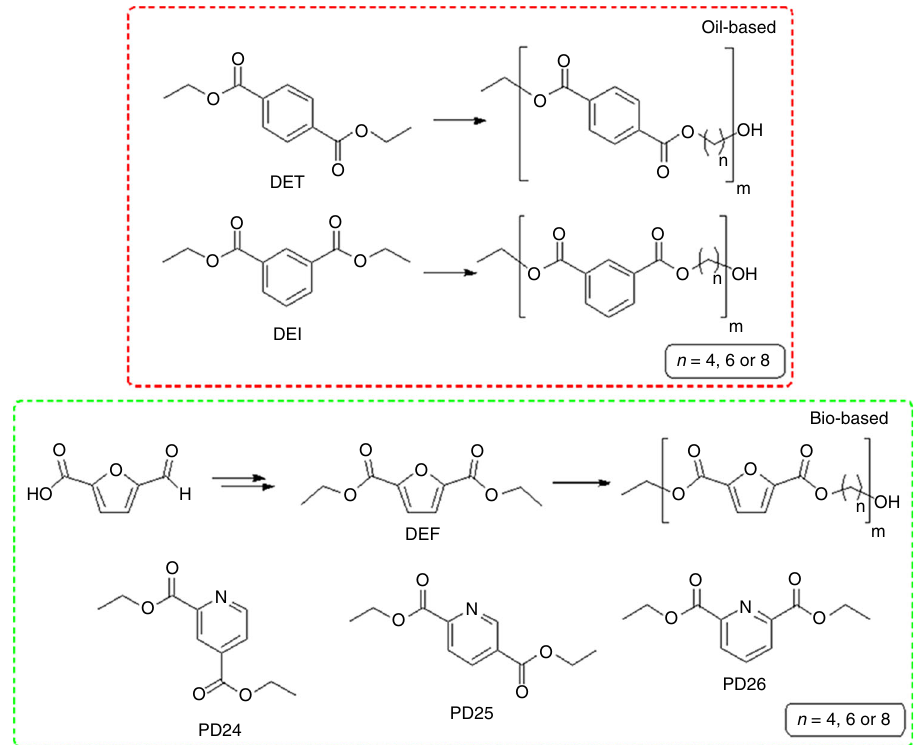
Fig. 1 Monomers used for the polycondensation reactions. Oil-based (top, red frame) and bio-based (bottom, green frame) monomers with related